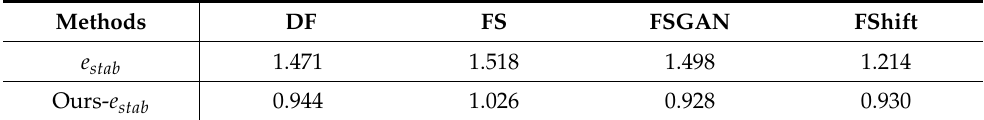
Table 1. Temporal coherence e stab comparison of different face-swapping methods. DF denotes Deep- fake, FS denotes FaceSwap, FSGAN denotes FSGAN, and Fshift denotes FaceShifter. Our framework can reduce the stability error of swapped results which represent better temporal coherence. Methods DF FS